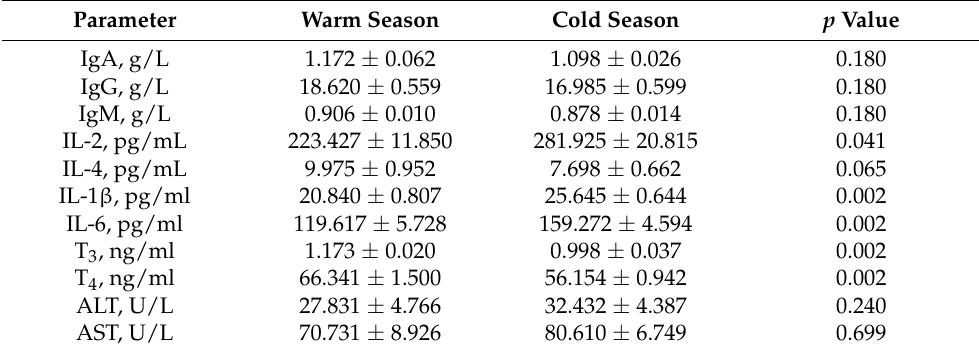
Table 5. Changes in serum metabolites, hormones, and immune-related parameters in grazing Mongolian sheep.